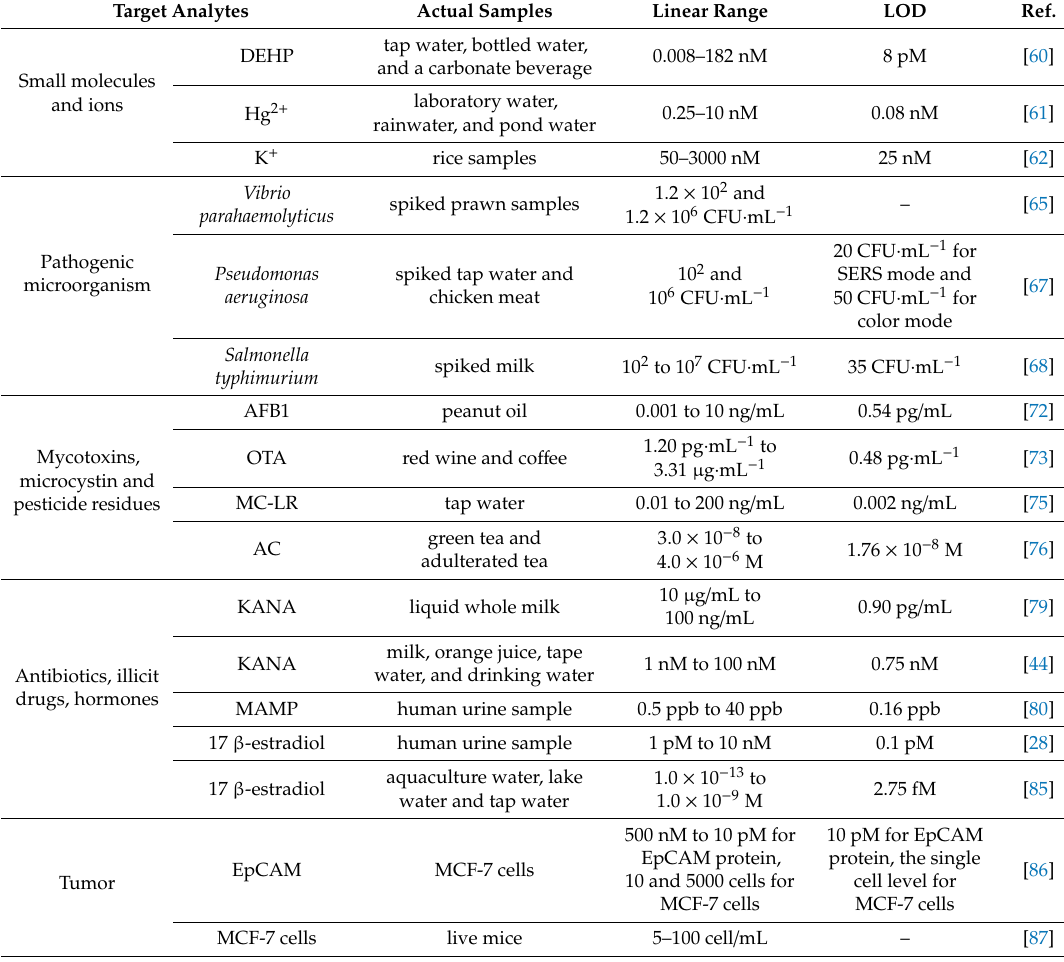
Table 1. Applications of aptamer-based SERS